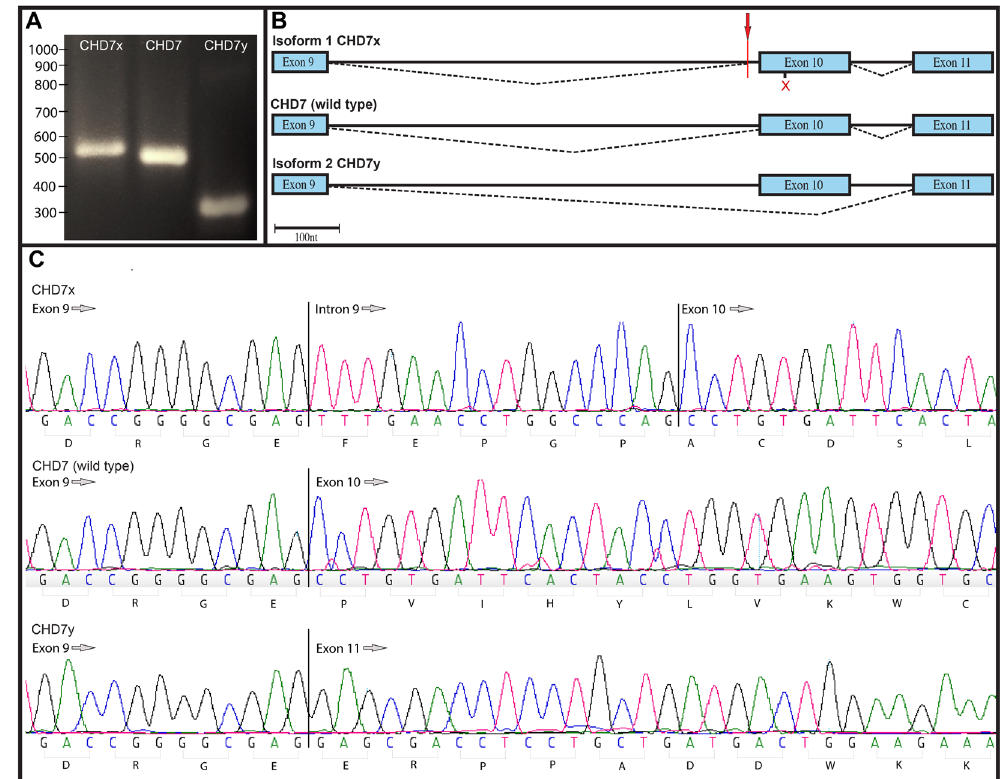
Figure 2. The Trooper mutation causes alternate Chd7 transcripts. ( A ) An agarose gel electrophoresis illustrating the three PCR products obtained from the blue/white screen. PCR products were stained using gel red and run through 2.5% agarose for 120 minutes at 80 V. ( B ) A schematic representation of splicing around the Trooper mutation in the three amplicons. Chd7 x retains 16 nt of intron 9 immediately following the mutation site (red arrow), resulting in frame shift which then causes a premature stop codon in exon 10 (red x). The wild type transcript is present as mice are heterozygous for the mutation and the smallest of the transcripts, Chd7 y is created by the skipping of exon 10 and remains in frame. ( C ) Sequence electropherograms of the three amplicons in the region of the Chd7 Trooper